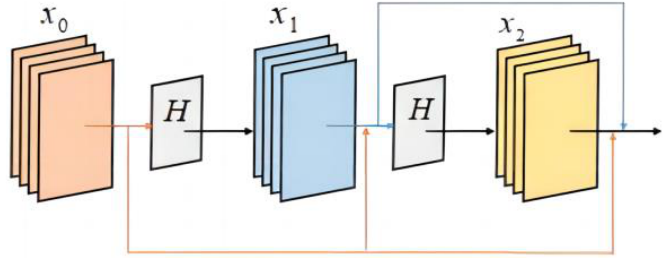
Figure 3. Densely connected